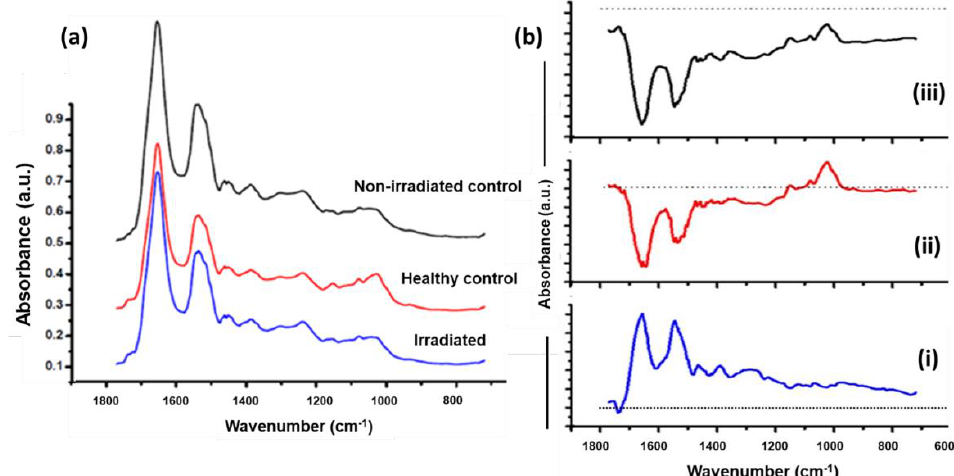
Figure 3. ( a ) Normalized mean spectra extracted from superficial region. Spectra are vertically offset for better visibility. ( b ) Difference spectrum. ( i ) Non irradiated control–irradiated. ( ii ) Healthy control–irradiated. ( iii ) Healthy control–non irradiated control. Dotted line indicates zero axis.